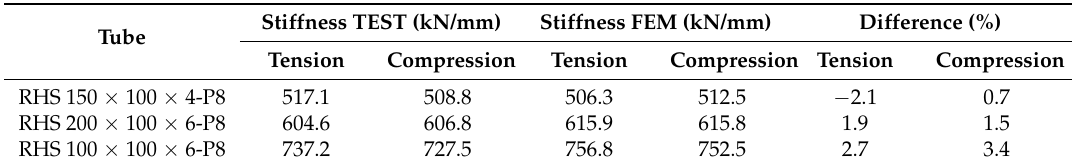
Table 2. Comparison of initial stiffness in